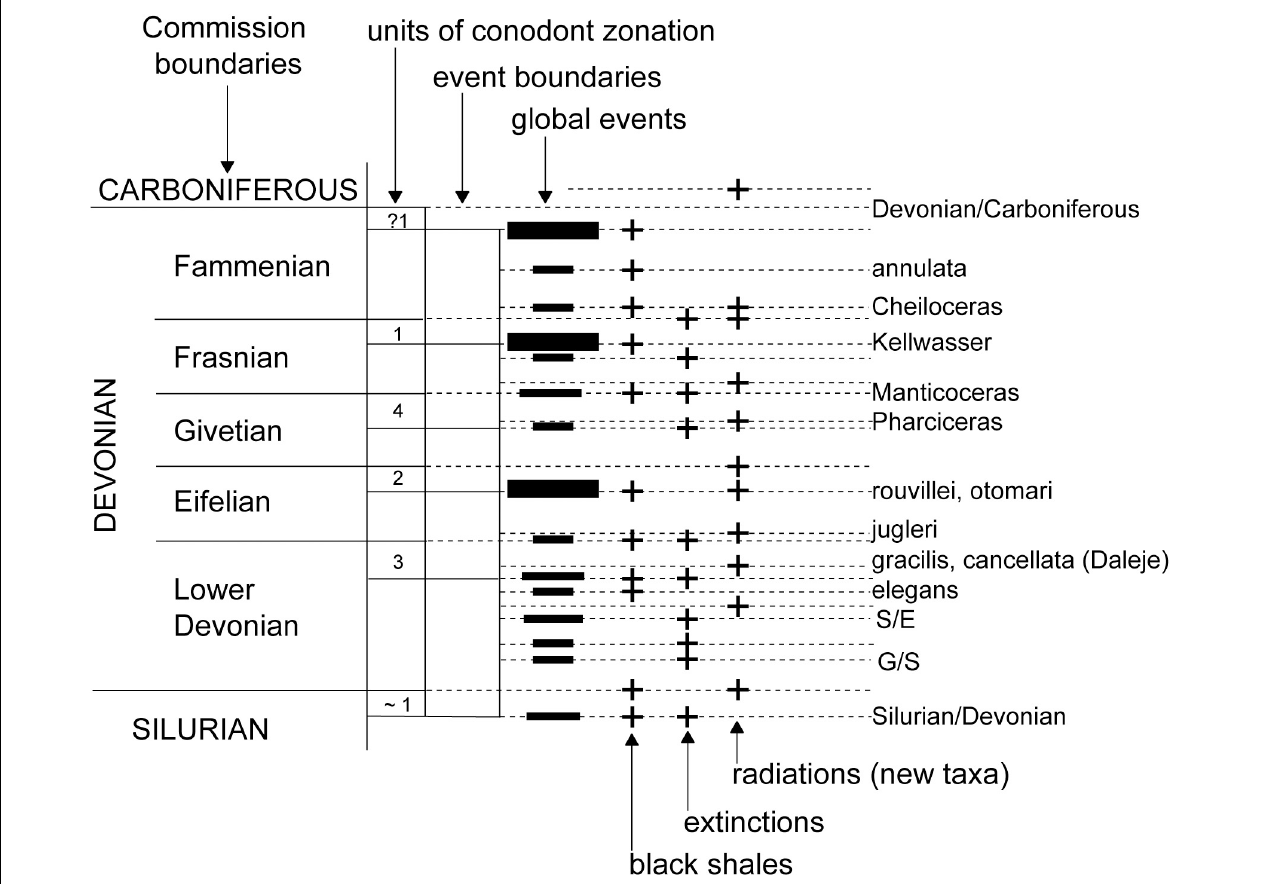
FIGURE 8 | A diagram showing the relationship between Devonian natural events and the proposed chronostratigraphic boundaries of the Subcommission on Devonian Stratigraphy (redrawn after Walliser, 1985; Figure 1 ; used with the permission of the copyright holder, Courier Forschunginstitut